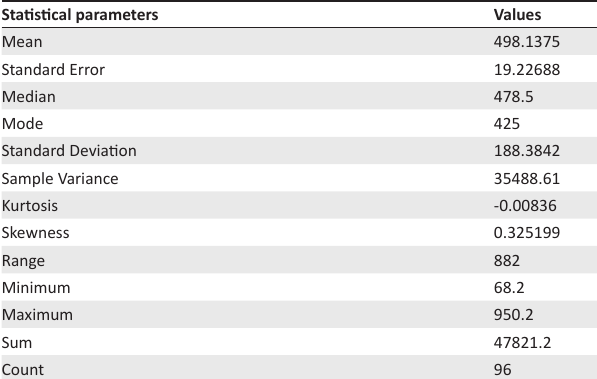
FIGURE 6: The annual rainfall of Grootfontein from 1917 to 2014 with a least square linear regression and 10–year moving average trend lines. TABLE 3: Descriptive statistics for the Grootfontein rainfall station derived from a 96–year time series: 1917–2014. Statistical